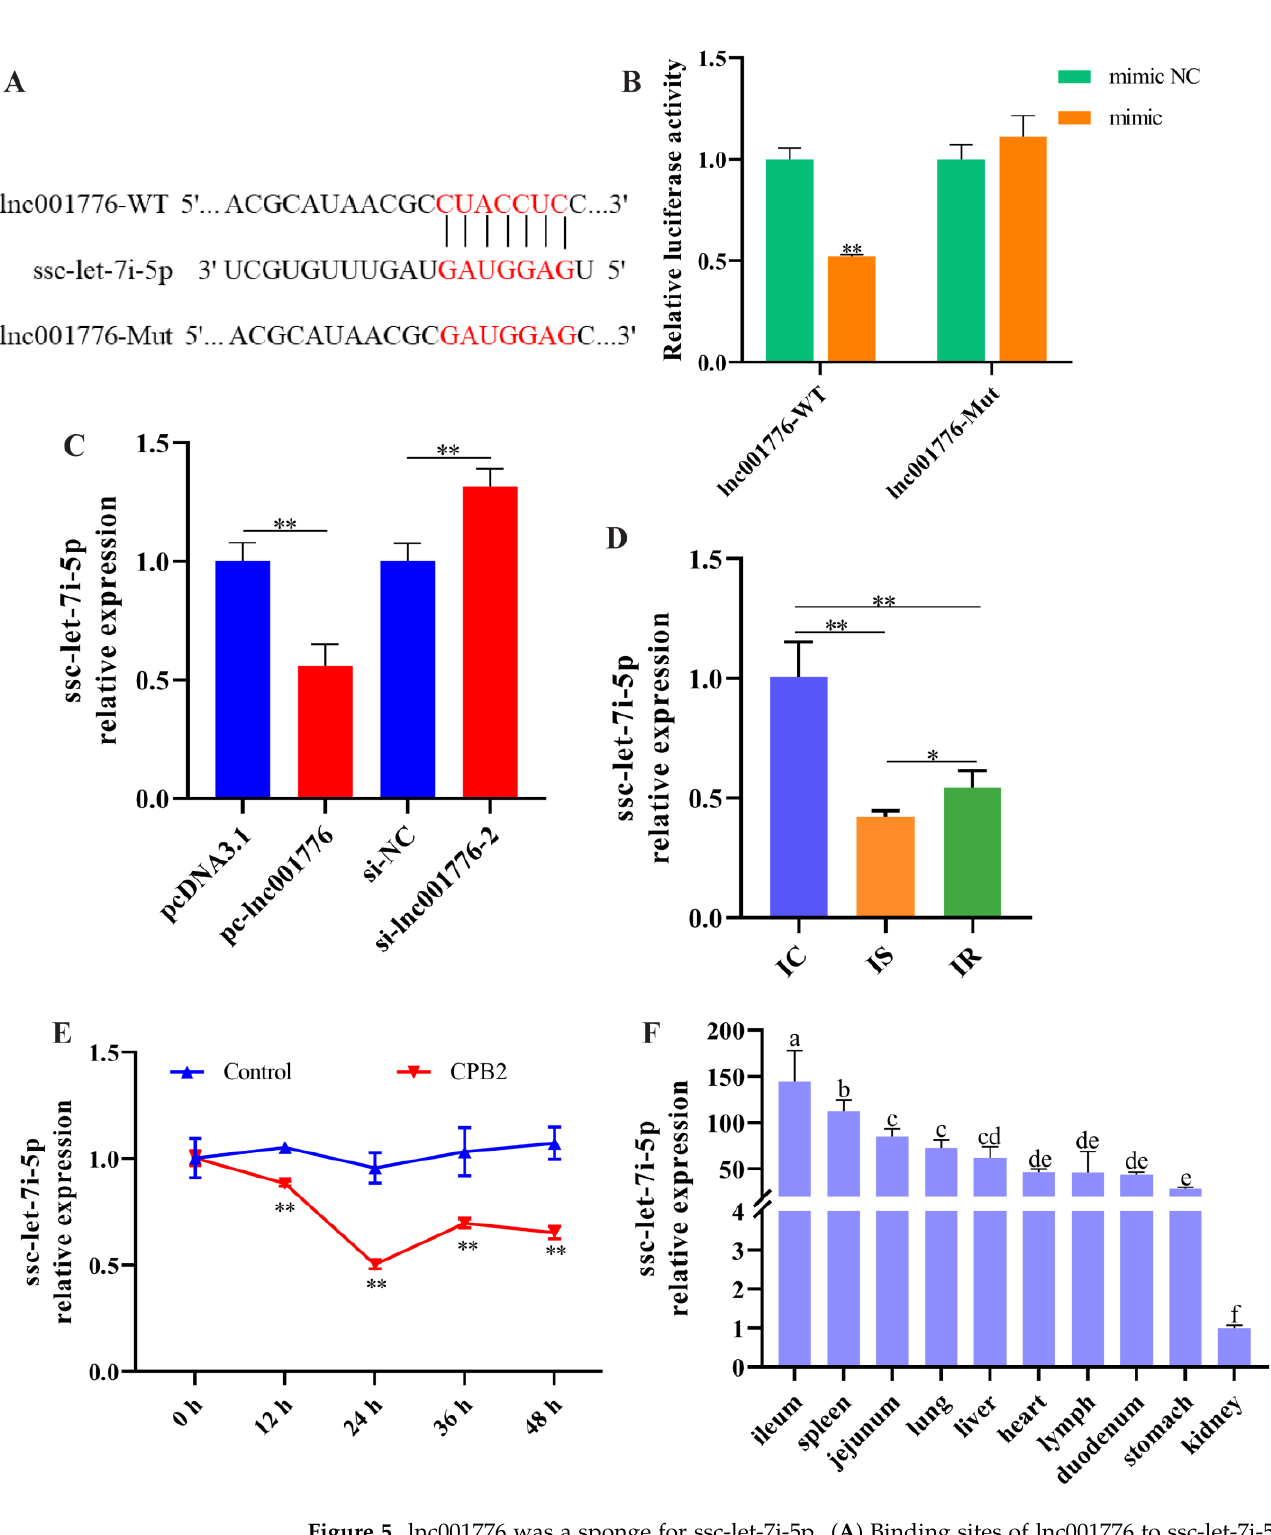
Figure 5. lnc001776 was a sponge for ssc-let-7i-5p. ( A ) Binding sites of lnc001776 to ssc-let-7i-5p. ( B ) Fluorescence activity through dual-luciferase reporter assay. ( C ) ssc-let-7i-5p expression after overexpression and knockdown of lnc001776 by RT-qPCR. ( D ) ssc-let-7i-5p expression in IC, IS and IR groups by RT-qPCR. ( E ) ssc-let-7i-5p expression in CPB2 toxin-infected IPEC-J2 cells via RT-qPCR. ( F ) ssc-let-7i-5p expression in different tissues of healthy piglets by RT-qPCR. Different lowercase letters indicate highly significant differences between groups ( p < 0.01). * p < 0.05, ** p <